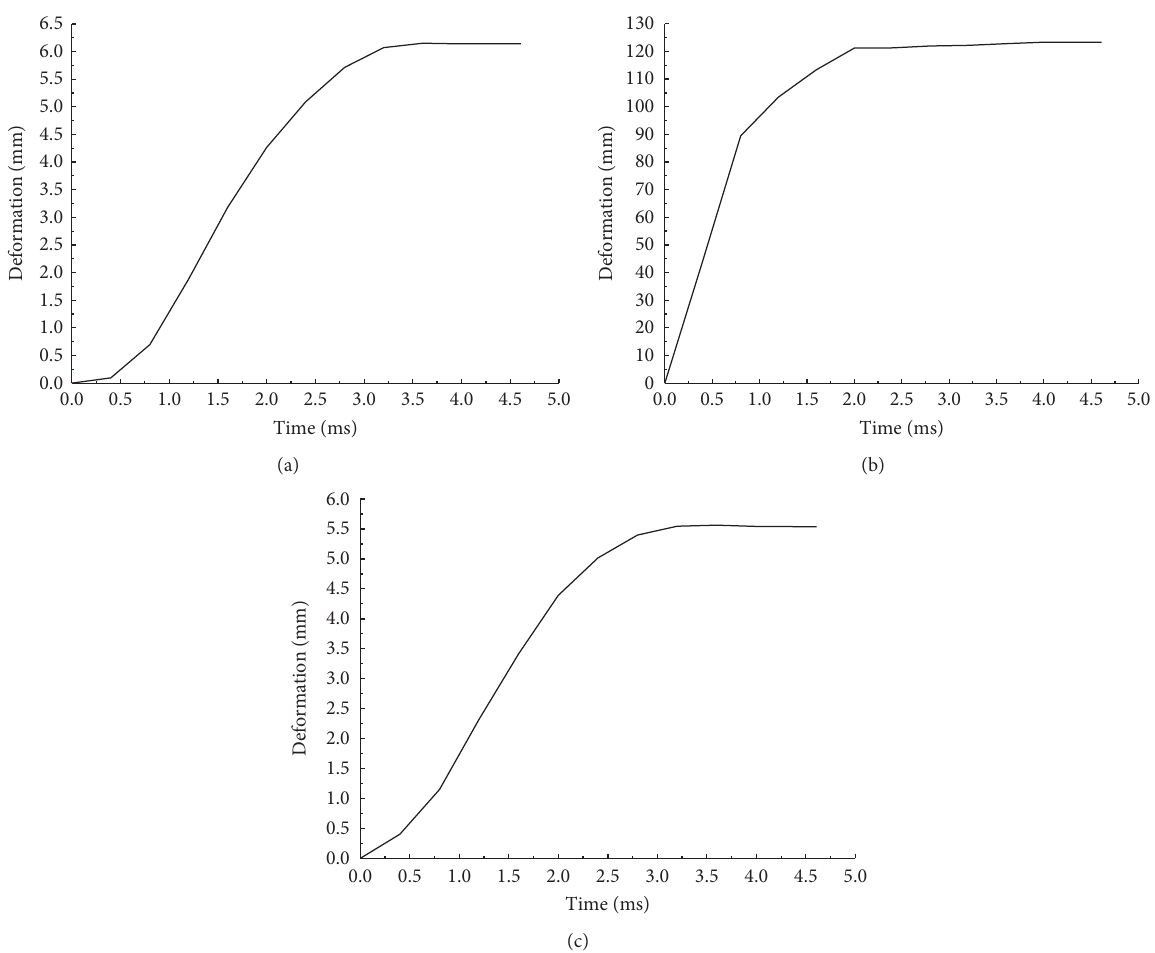
Figure 15: Deformation-time curves at different positions of the column surface facing the explosive. (a) Bottom of column. (b) Middle of column. (c) Top of column (NSS).